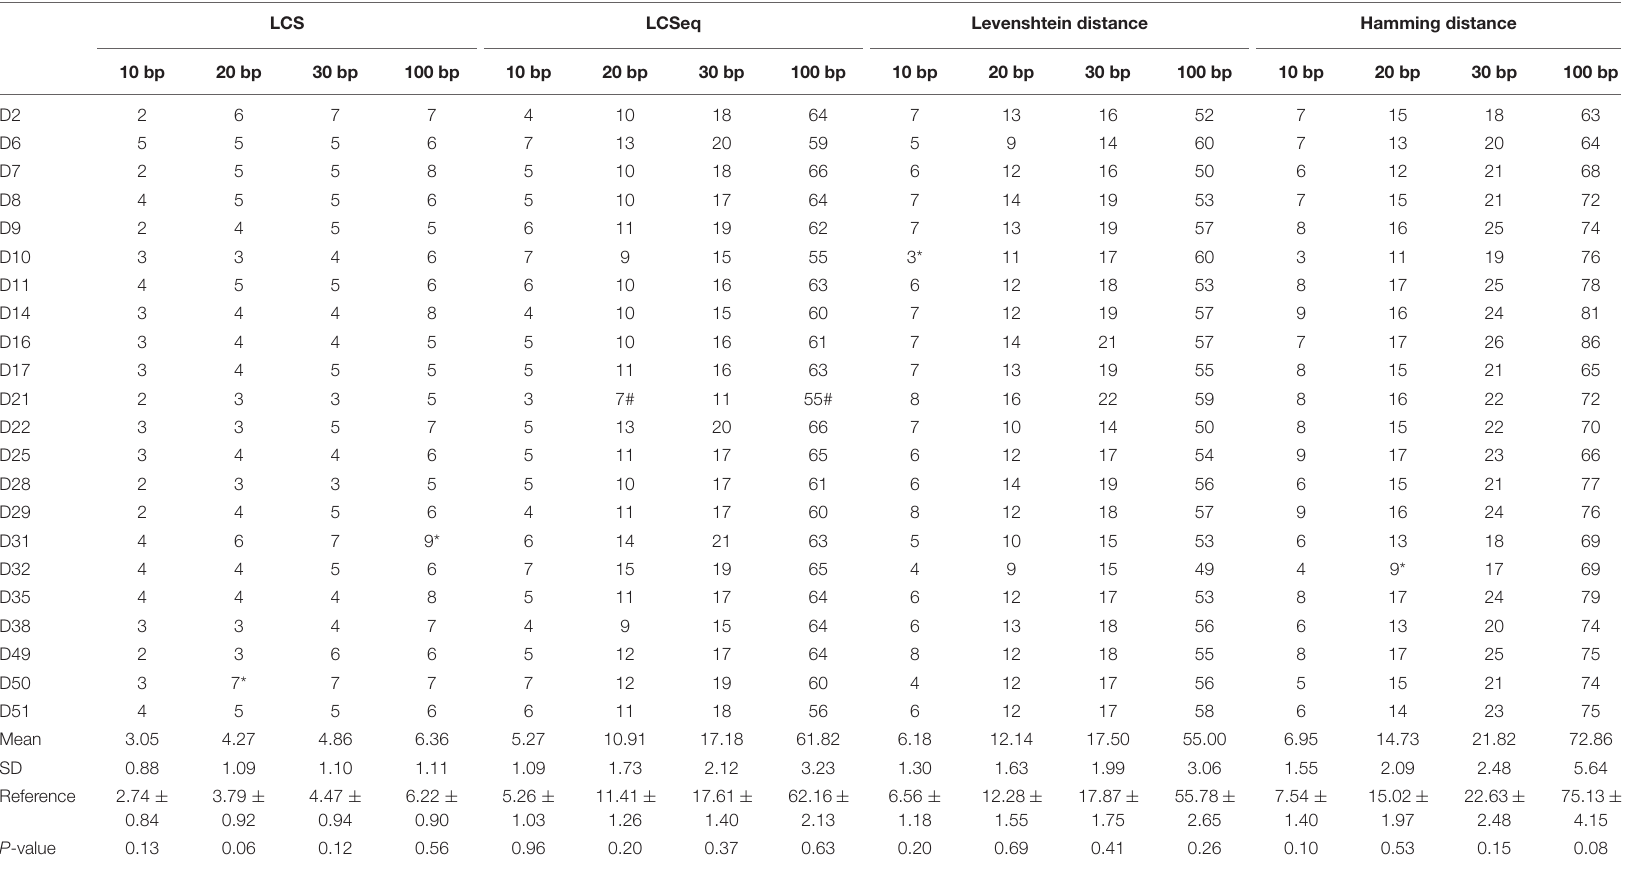
TABLE 4 | Similarity analyses of the root area of potential hairpin